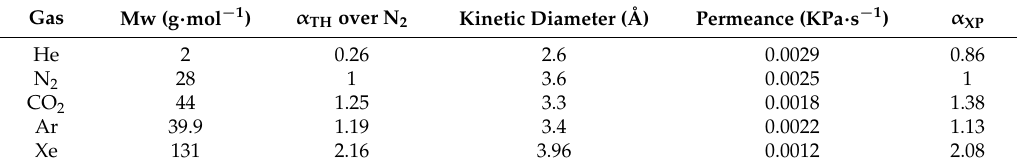
Figure 1. Representative scanning electron micrographs (SEMs) of the ZiF8@CNT membranes with ( A ) surface and ( B ) cross-section of a pristine CNT BP; ( C ) and ( D ) structure of the MOF membrane upon ZiF-8 growth with macron sized, acting as pore matrix for sieving, and nano-sized crystals, used for anchoring the larger ones, across the surface and cross section, respectively. Table 1. Permeation coefficients of the membranes and main properties of the gases used. The kinetic diameters, molecular weight (Mw), and theoretical Knudsen diffusion were taken from [12], while the selectivities (theoretical, α TH and experimental α XP) were calculated from the data shown in Figure A2.